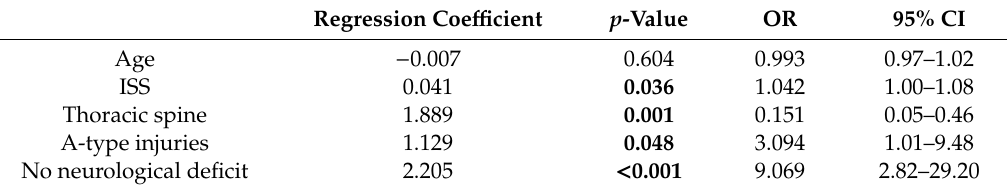
Bold marked values indicate significant parameters. OR: odds ratio.